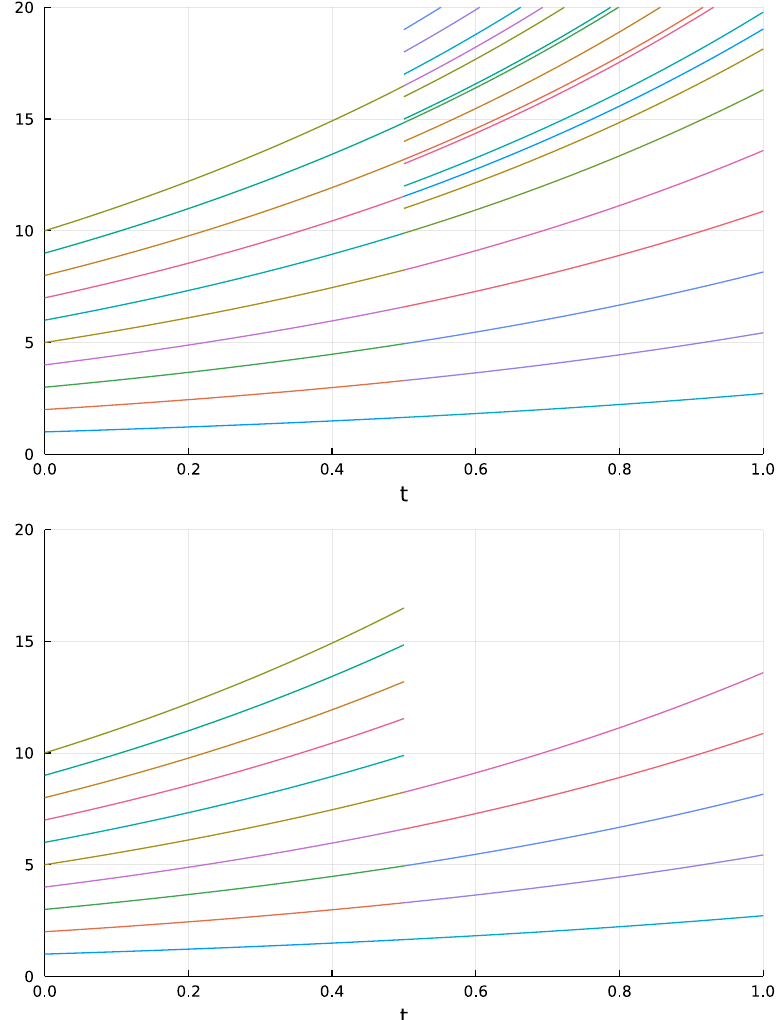
Figure 8. The results of simulating Listing 3 ( Top ) and Listing 14 ( Bottom ). The structural change and subsequent recompilation of the model occur at t = 0.5 seconds. The curve in the graph represents all x i variables of x −→ in Listing 3 and Listing